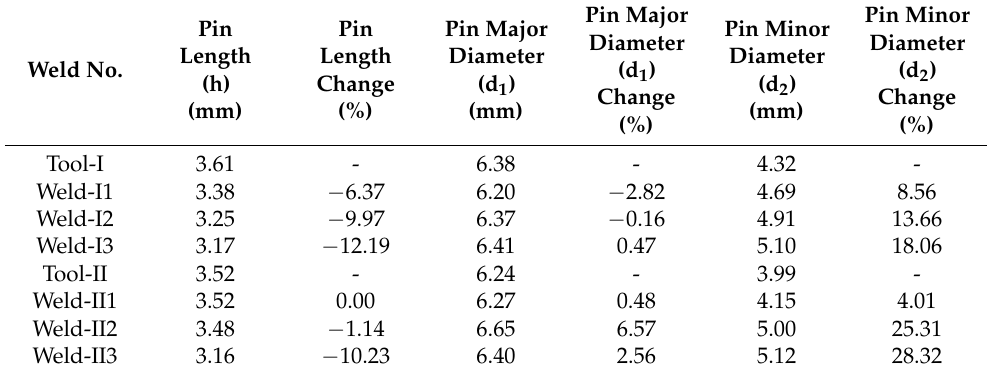
Figure 13. The progressive variation in the tool pin geometry when welding at 1200 rpm and traverse speeds of ( a ) the initial tool under a no-weld condition, and under ( b ) 30, ( c ) 60, and ( d ) 90 mm/min. Table 8. The alterations in pin length, and the major and minor diameters of the conical pin with successive weld runs.